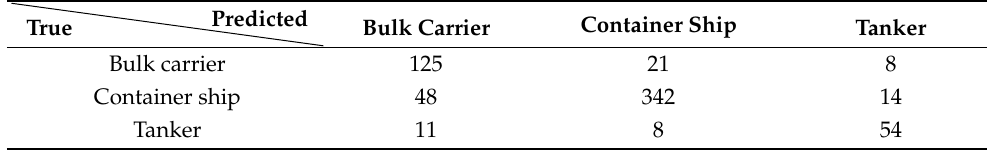
Table 6. Confusion Matrix of the Six-Category